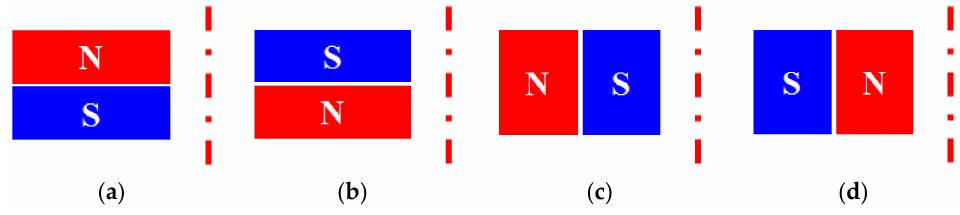
Figure 8. Polarity direction of the permanent magnet.